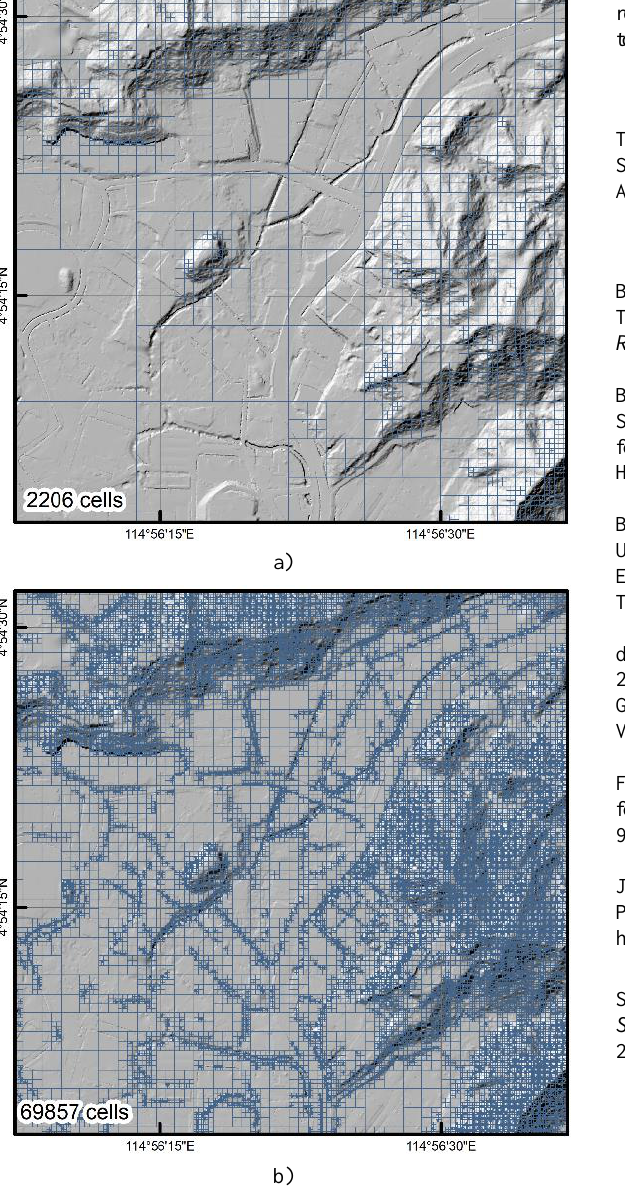
Figure 4. Hillshadow DTM Overlaid with the Q-Tree Containing 2206 cells a) and 69,857 cells